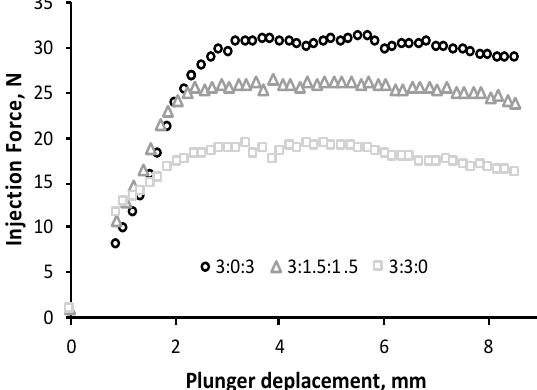
Figure 6. Injection force profile using a 5–mL syringe (12 mm of inner diameter) with an 18G needle of CHT:PCDi:PCDs hydrogels at a crosshead speed of 10 mm/min at room temperature. The curves correspond to the average values of three experiments.